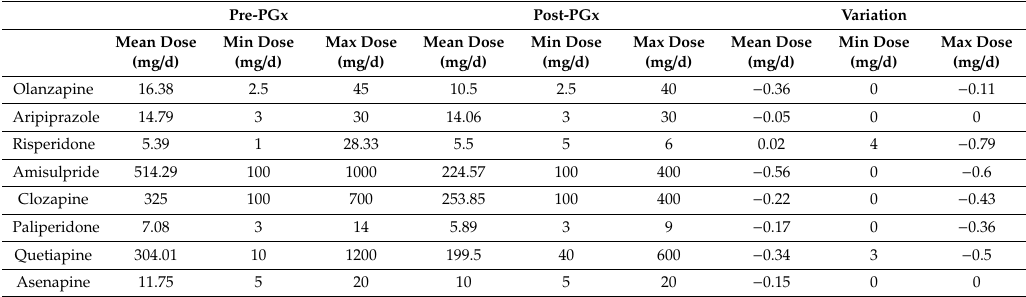
Table 9. Mean, Min, and Max Daily Dose prescribed to the study